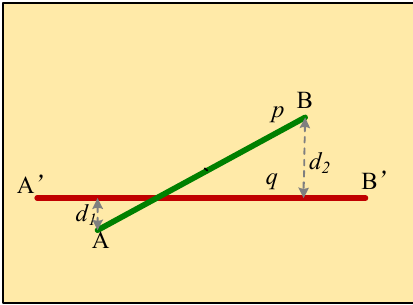
( c ) Figure 7. Experimental data: ( a ) location map of experimental area ( b ) LiDAR point clouds and ( c ) aerial optical image.